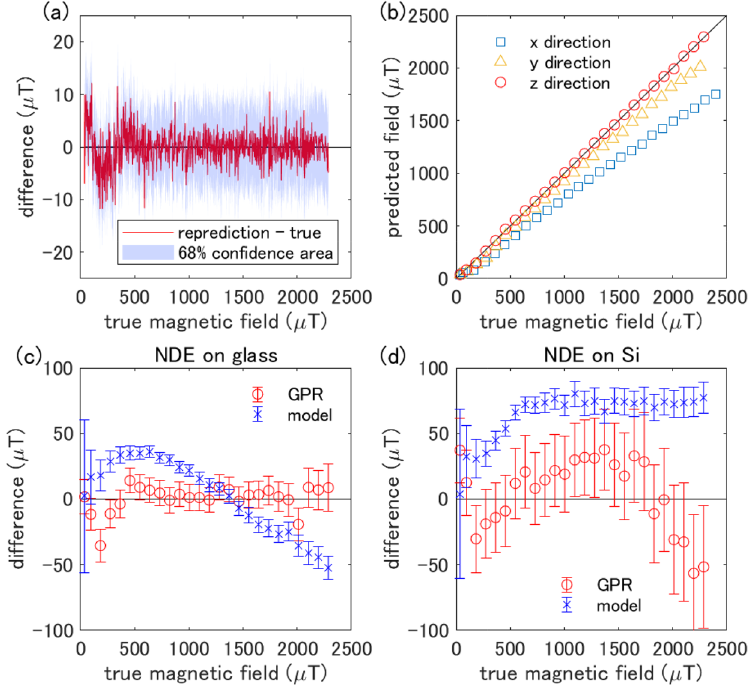
Figure 2. Performance evaluation of GPR and comparison with the physical model. ( a ) Benchmark of reprediction by GPR. The horizontal axis is the true magnetic field, and the vertical axis is the difference between the repredicted field and the true field. The light purple region is the standard deviation interval. ( b ) Dependence of the predicted magnetic field on the magnetic field directions. The black line is the ideal value where the predicted and true magnetic fields perfectly agree for the z-direction. ( c , d ) The detail of the prediction accuracy for the NDE ( c ) on the cover glass and ( d ) on the silicon wafer. We use only the training data when the field is applied to the z-direction. The difference between GPR predicted and true field is shown by a red circle. The corresponding result using the fitting based on the physical model 14 is shown by a blue cross. The error bars depict a 68% confidential interval. Note that we have corrected the data for NDE on silicon regarding the heating of the material (see Fig. S3 for